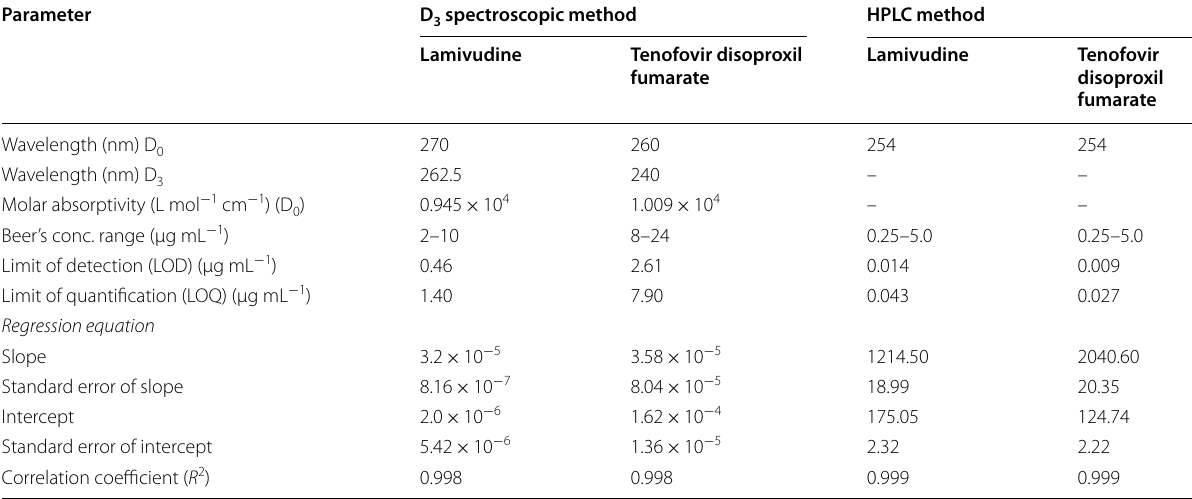
Table 1 Optimum conditions for drug assay by proposed methods